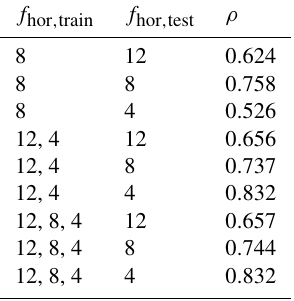
Table 3. Pearson correlation coefficients ρ between ANN predic- tions ( n hidden = 64) and DNS values averaged for all three test flow fields, all heights, and all correction and dissipation terms. The dif- ferent coarse-graining factors used during training, f hor , train , and testing, f hor , test , are indicated. Here, the third row refers to the train- ing and test configuration used in Sect. 4.1.1. More details about all the indicated training and test configurations are given in Sect. 3.5.1. f hor ,